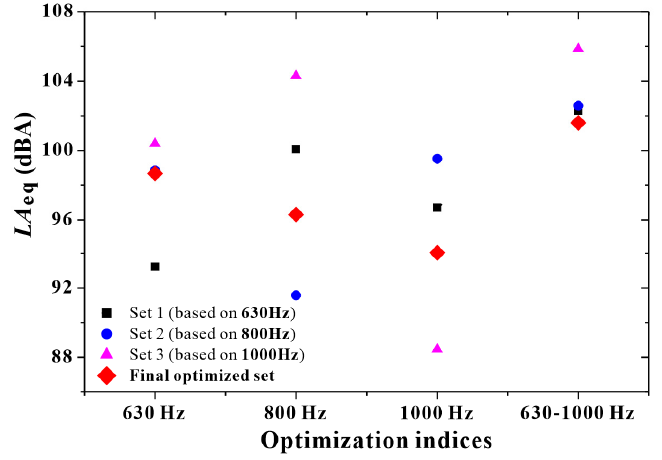
Figure 10. Comparisons of the acoustic performance of the optimized sets of parameters under different optimization indices.